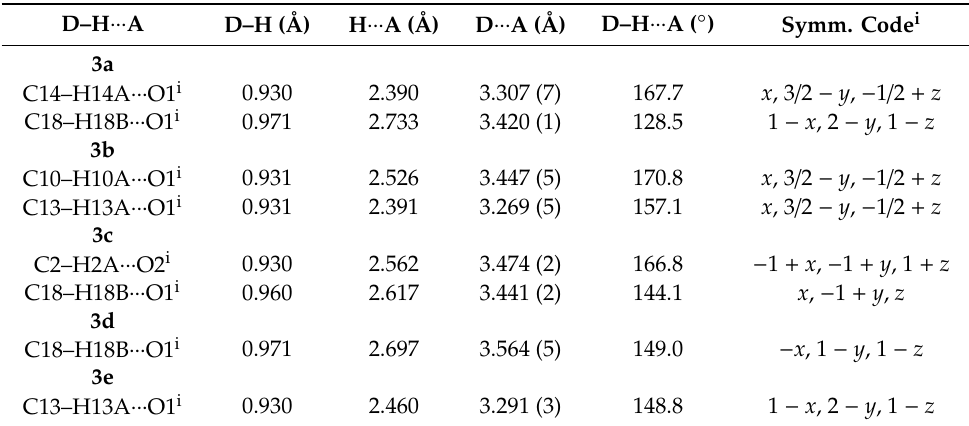
Figure 2. Atom numbering and thermal ellipsoids drawn at 30% probability level ( A ), hydrogen bonds, ( B ) and C–H··· π interactions ( C ) in 3b .